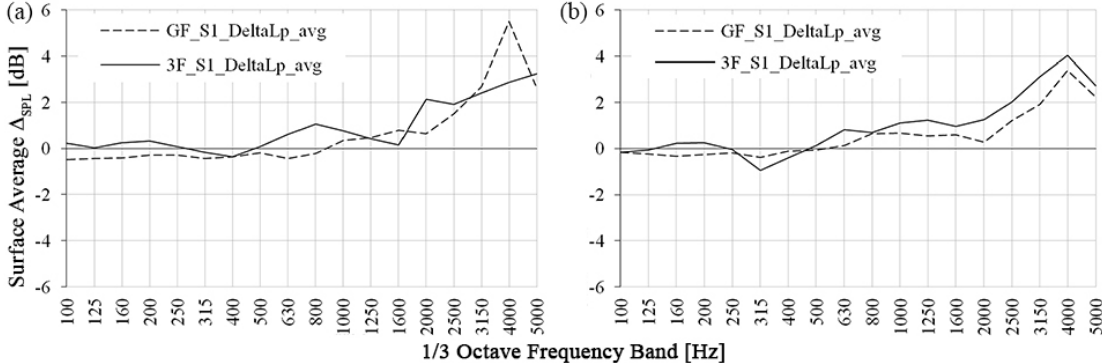
Figure 11. Δ SPL calculated between SPL on the glass surfaces of windows averaged over all the microphone positions. Ground floor (dashed line) and third floor (solid line). Source position in S2 , as it is in Figure 4. ( a ) Δ SPL = A SPL − C1 SPL ; ( b ) Δ SPL = A SPL − C2 SPL . Configurations A, C1, C2 are as they are in Figure 3.